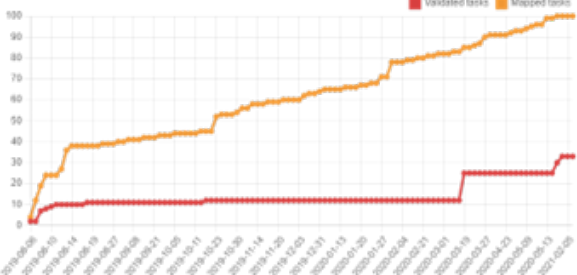
Figure 15: Contribution Timeline of LVM for Gokana LGA